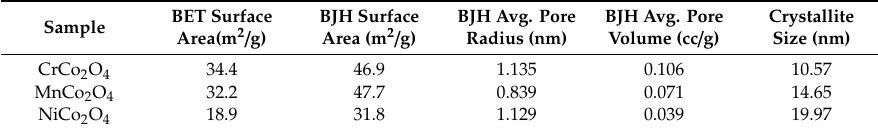
Table 1. Crystallite size and physical properties of MCo 2 O 4 (M = Cr, Mn, Ni) determined using XRD,